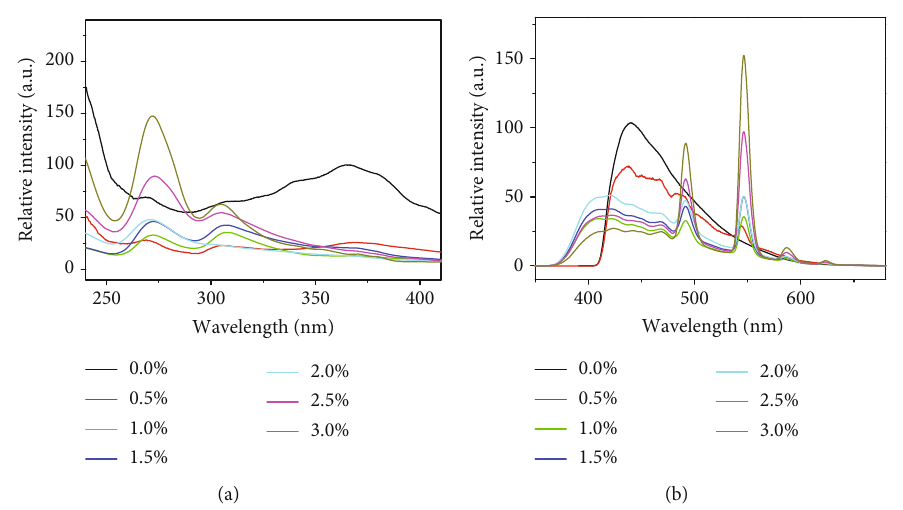
Figure 7: Luminescence properties of rare earth UV-cured composite: (a) excitation spectra and (b) emission